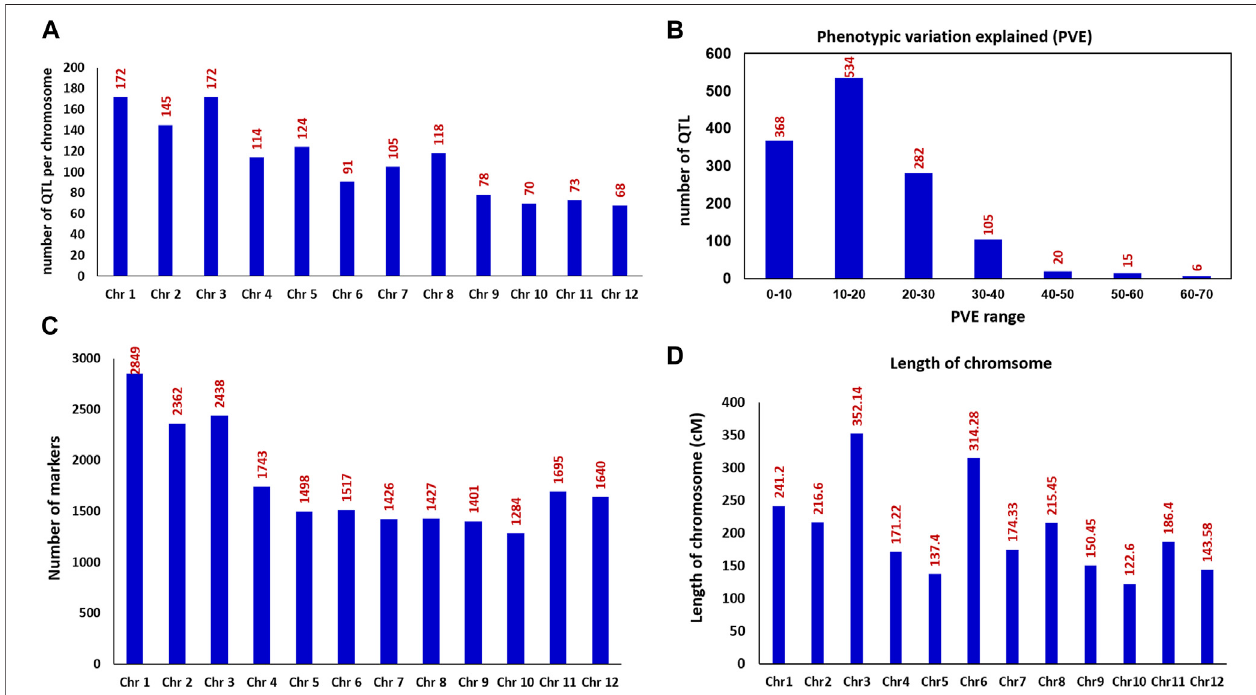
FIGURE 1 | Frequencies of QTL and details on the mapped markers used for the identi fi cation of MQTLs in rice (A) Number of QTLs present on the 12 rice chromosomes (B) Frequencies of the QTL with different levels of phenotypic variation explained (PVE%) (C) Frequencies of the mapped markers on each of the 12 rice chromosomes (D) Length/size of the rice genetic map in cM (centimorgan) across 12